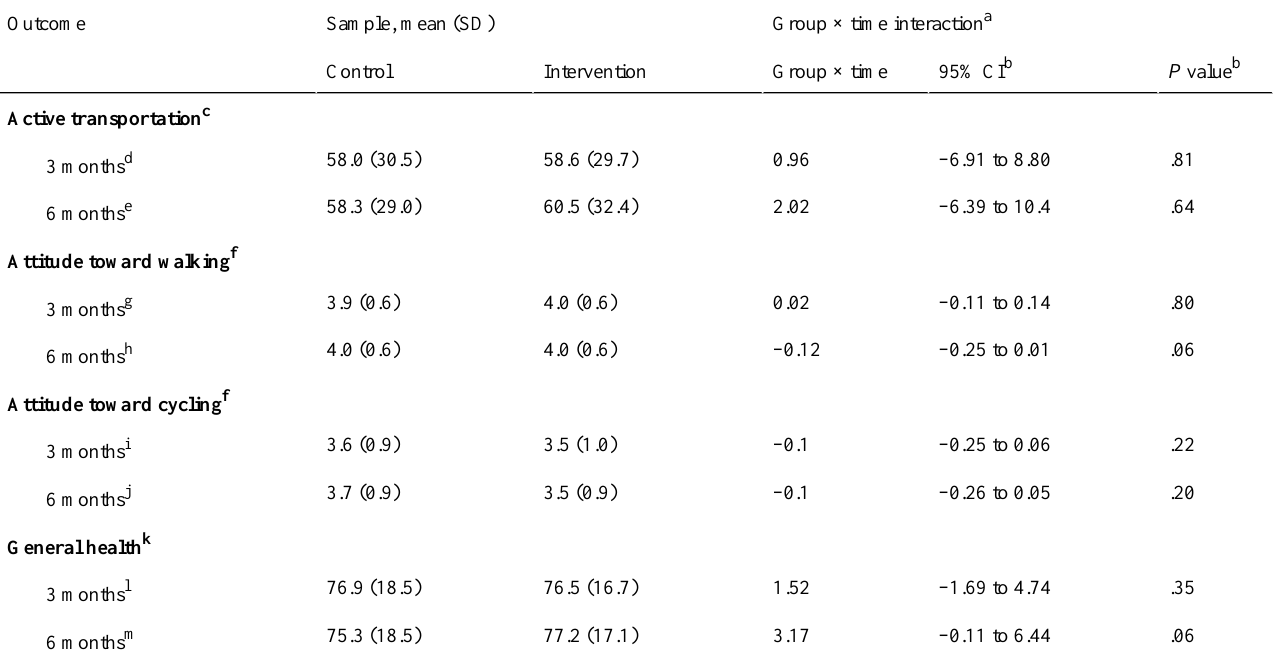
Table 2. The intervention effect on the secondary outcomes at 3 and 6 months.